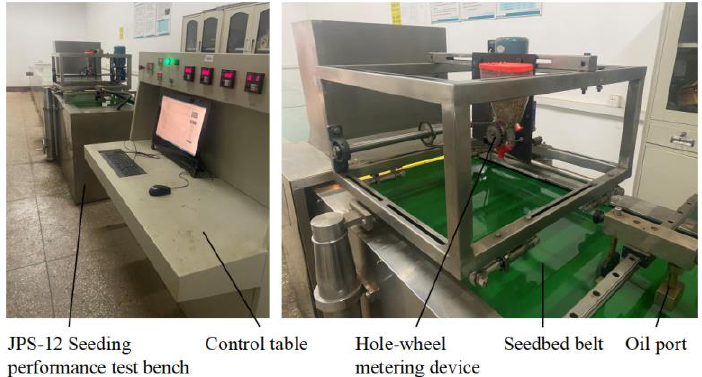
Figure 9. JPS-12 Seeding performance test bench.